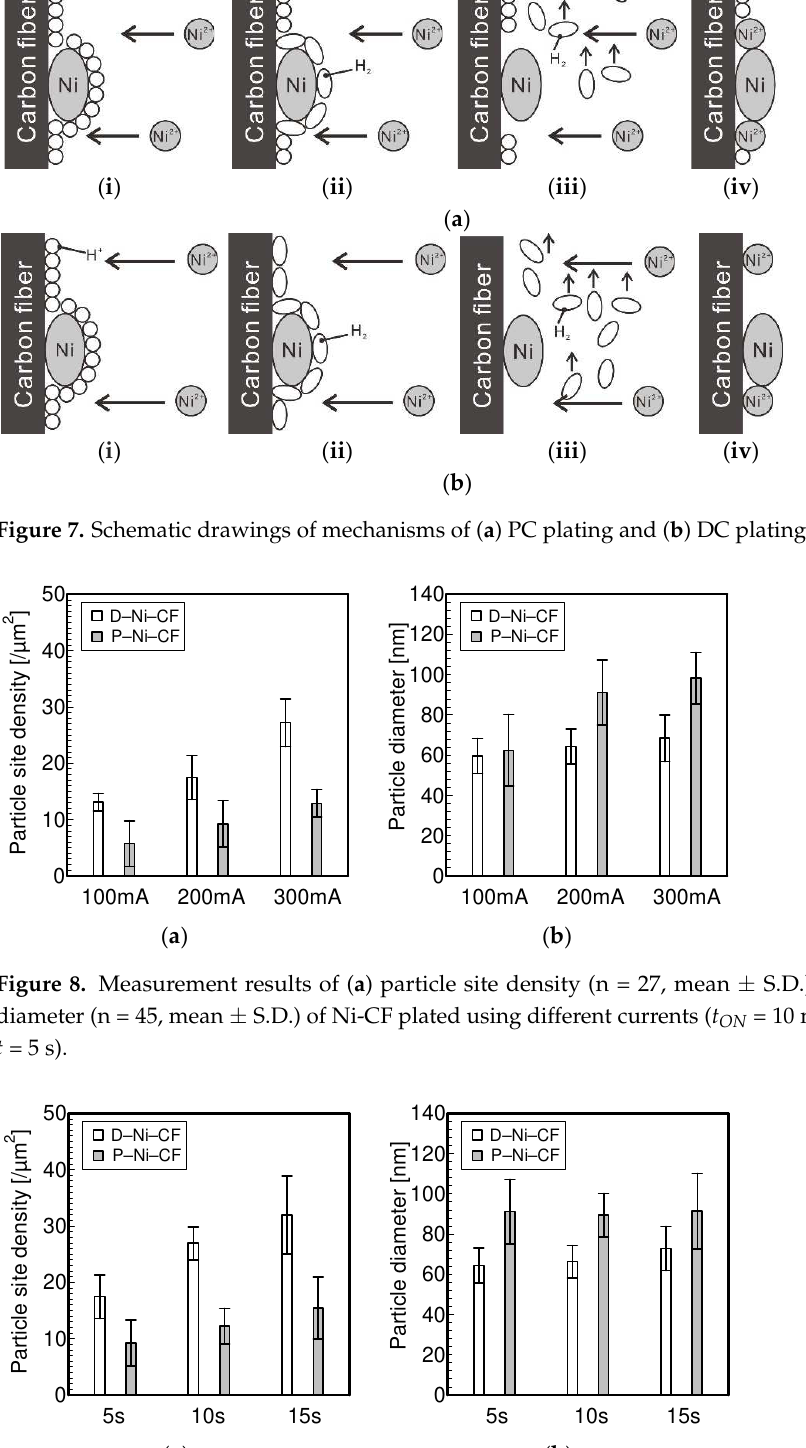
Figure 10. FE-SEM images of actual total plating time: ( a ) 5 s, ( b ) 10 s and ( c ) 15 s of P-Ni-CF ( I = 200 mA, J = 3.79 A/m 2 , t ON = 10 ms, t OFF = 100 ms, t = 5 s).